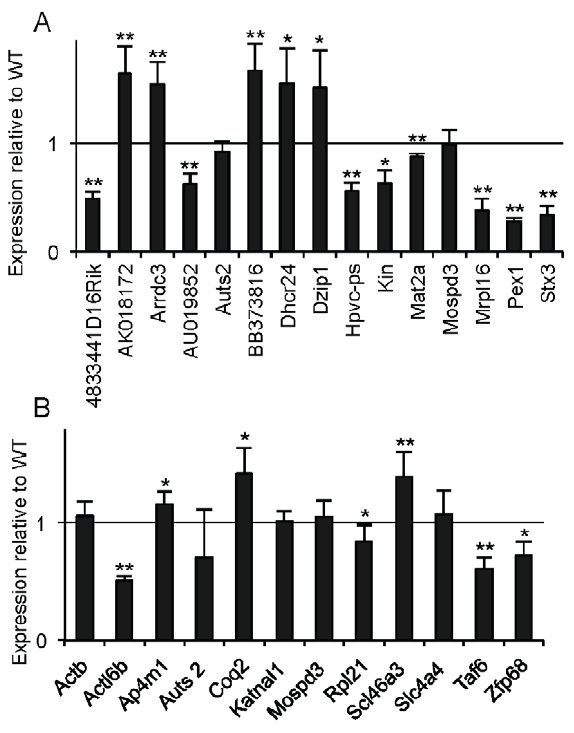
Figure 2. qRT-PCR of candidate genes in P0 brain from mice of different genetic backgrounds. Expression values are shown relative to the housekeeping gene Sdha . (For presentation purposes, some values were scaled as indicated). WT 129S1/SvImJ (n=7), Gtf2ird1 2 / 2 (n=5), WT CD1 (n=6). * p , 0.05, ** p , 0.005 using Student’s t-test.